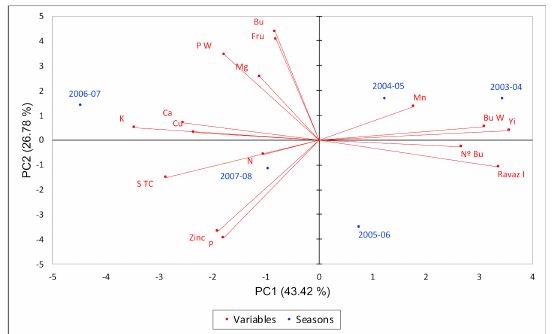
Figure 2. Principal component analysis (PCA) performed with yield, vigor, and nutritional variables obtained from Syrah grapevines according to the study seasons. Footnote: the distribution of variables (red lines) and individual observations according to seasons (blue dots) on PC1 and PC2 are shown. Yi: yield, N ◦ Bu: number of bunches per plant, Bu W: bunch weight, Bu: budburst, Fru: fruitfulness, P W: pruning weight, Ravaz I: Ravaz index, S TC: scion trunk